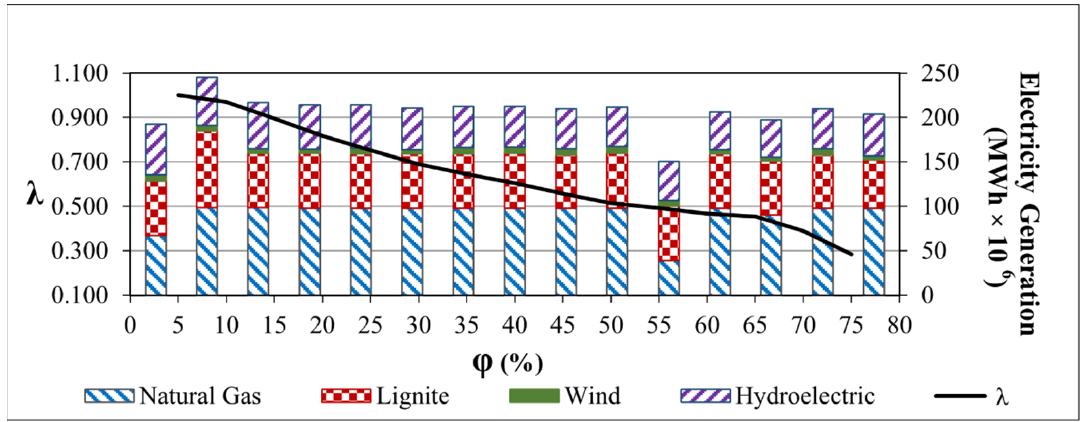
Figure 7. The relationship between φ , λ , and electric energy generation.